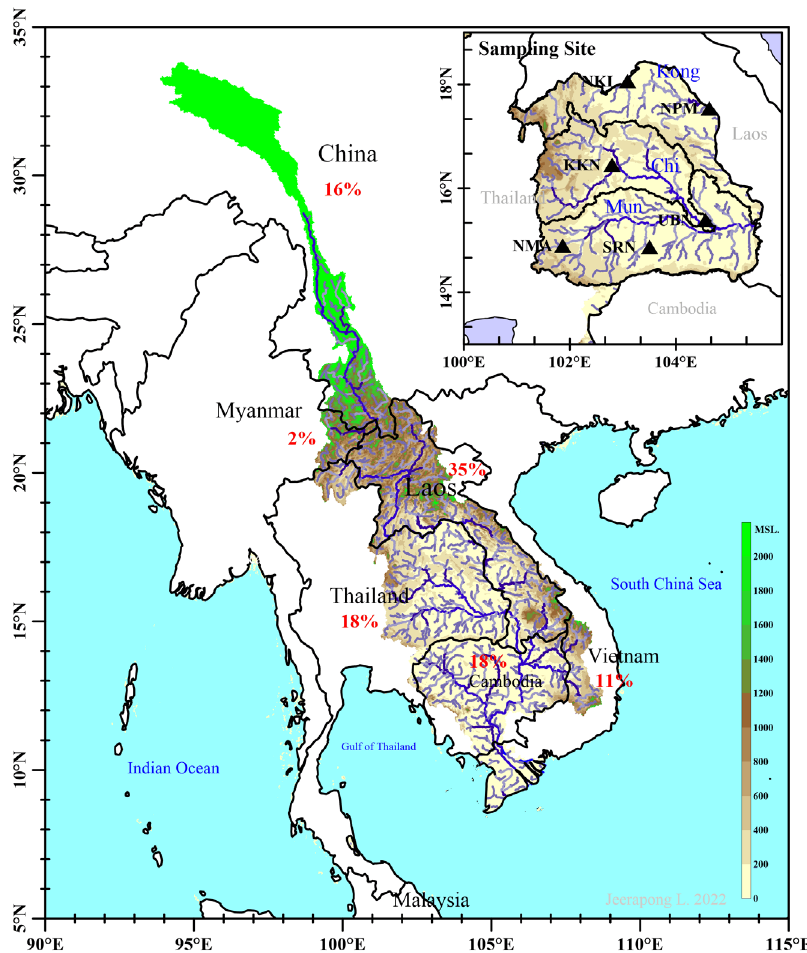
Figure 1. Tributaries of the Lower Mekong River Basin in Thailand. The percentage values denote the area of each country in the Mekong River Basin. Triangular points denote sampling locations (Nongkhai station (NKI), Nakhon Phanom station (NPM), KhonKaen station (KKN), Nakhon Ratchasima station (NMA), Surin station (SRN), and Ubon Ratchathani station (UBN)).